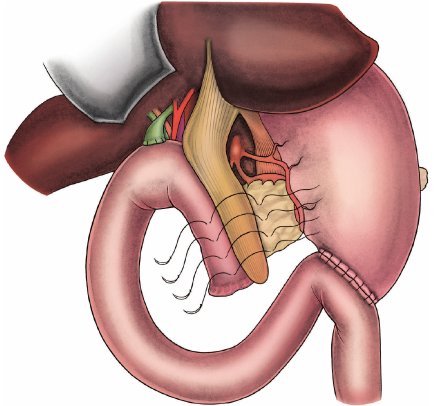
Figure 2: The mobilized ligamentum teres hepatis is placed onto the dehiscence side as a patch and fixed with interrupted sutures that were put on both pancreas and jejunum.